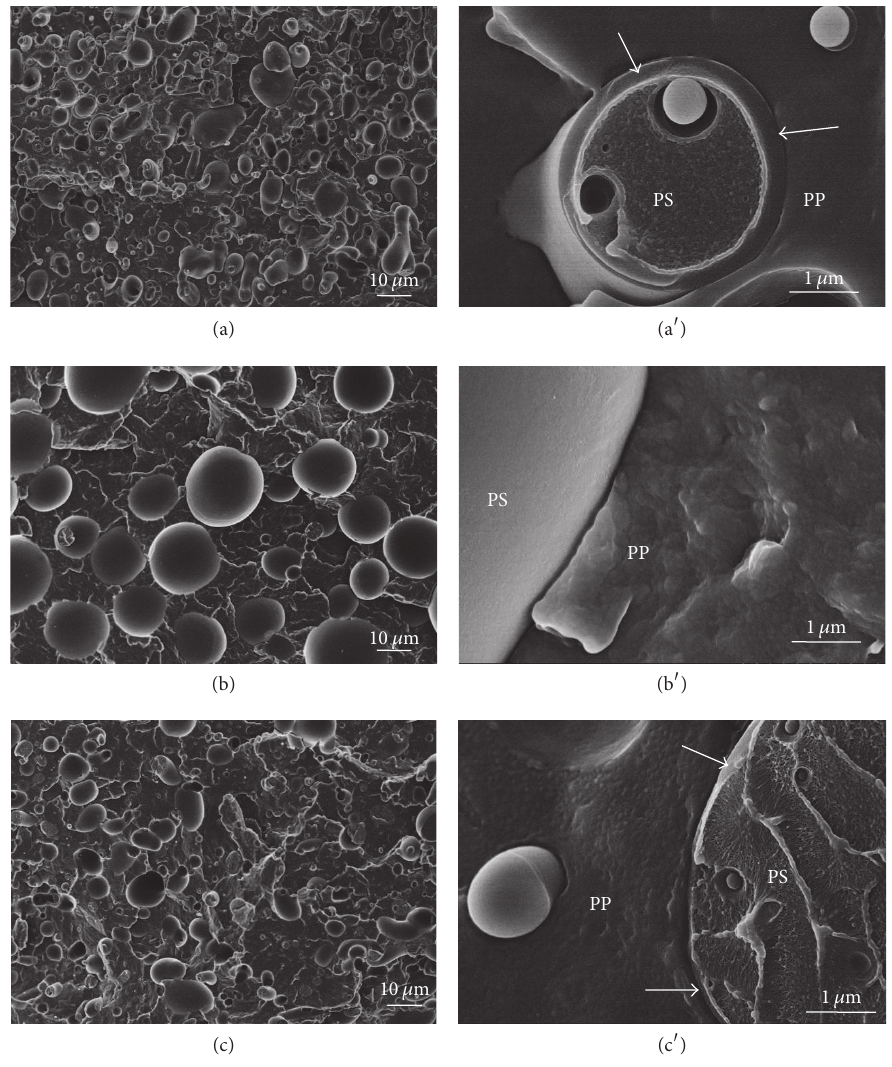
Figure 6: FESEM images showing the phase morphologies of 0.2 wt% aGO in representative composites. [(a) and (a 󸀠 )] aGO/PP/PS; [(b) and (b 󸀠 )] (PS/aGO)/PP; [(c) and (c 󸀠 )] (PP/aGO)/PS (the region pointed by arrows is the “ transition zone